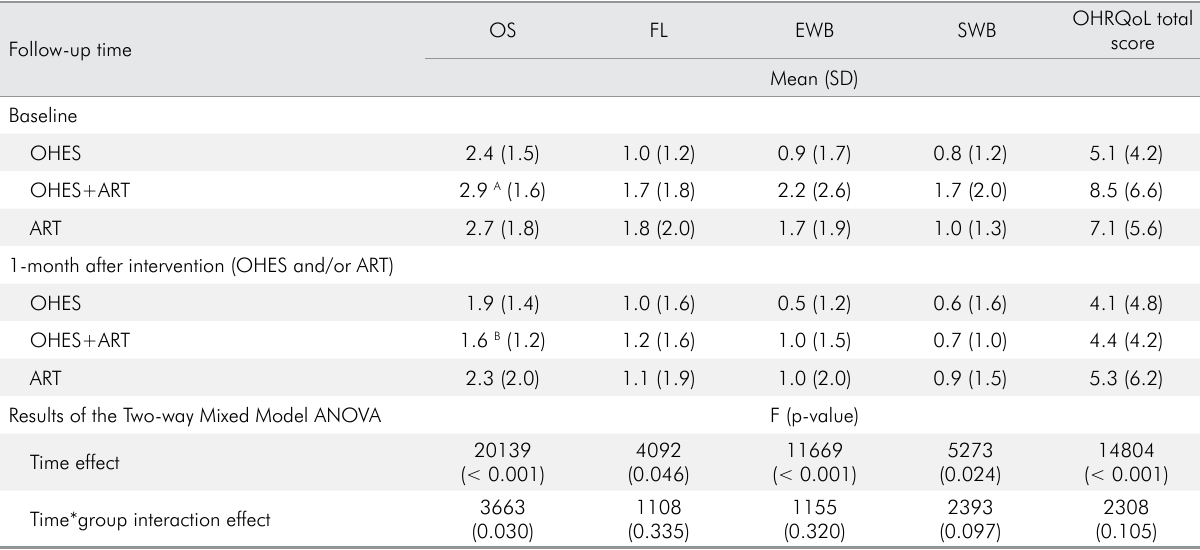
Table 1. Follow-up description of samples according to CPQ8-10-ISF:16 scores and the interaction effect of time*group : a two- way mixed model